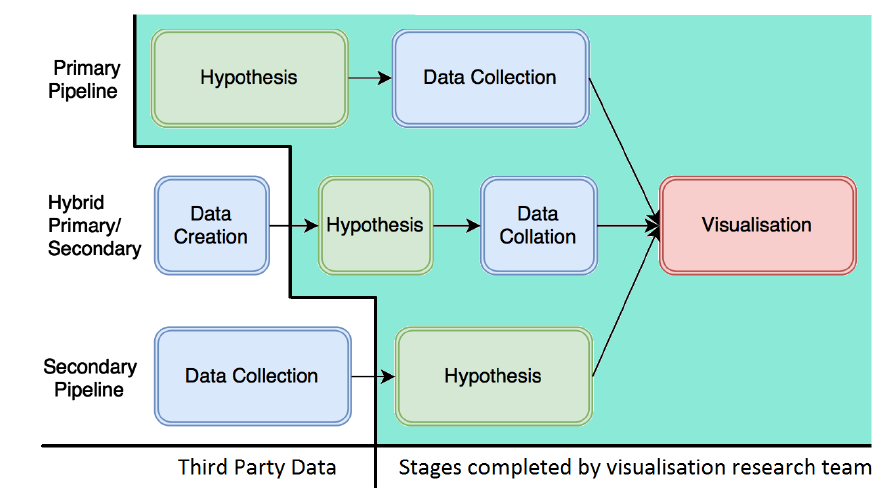
Figure 2. The differences between primary and secondary data sources in visualisation. Research involving primary data proposes the visualisation hypothesis before the data is collected (a priori hypothesis), hereas research involving secondary data proposes the visualisation hypothesis with the knowledge that the data has already been collected (a posteriori hypothesis). The hybrid pipeline contains two stages of data collection pre and post hypothesis. The initial creation of the data is often in the context of social media. At this point, the data are not collected to support the hypothesis posed by the visualisation research. Once the visualisation hypothesis is formulated, the data can then be scraped and collated into a second structured dataset for the purpose of visual